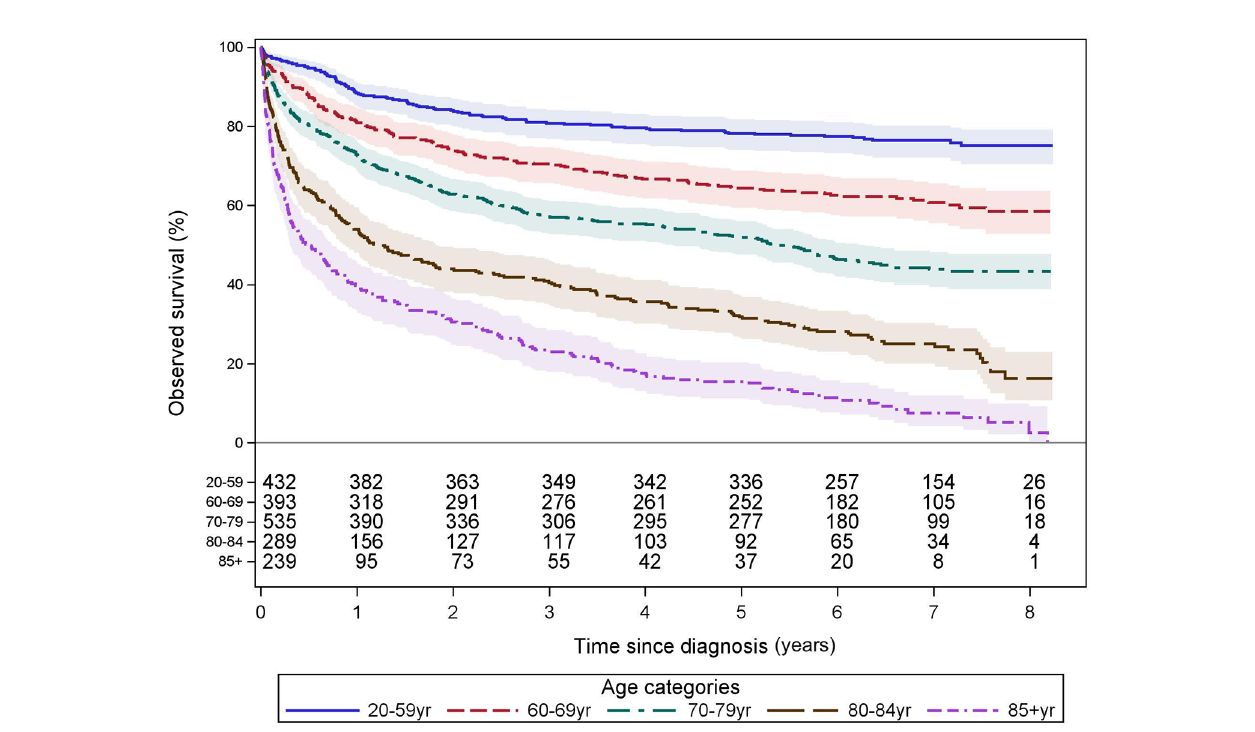
FIGURE 1 | Observed survival by age categories. These Kaplan – Meier curves show the observed survival from time of diagnosis, of all 1,888 patients, grouped into 5 clinically relevant age categories associated with a signi fi cantly different overall survival from time of diagnosis. The numbers of patients at risk are tabled below the curves. Colored areas represent the 95% con fi dence